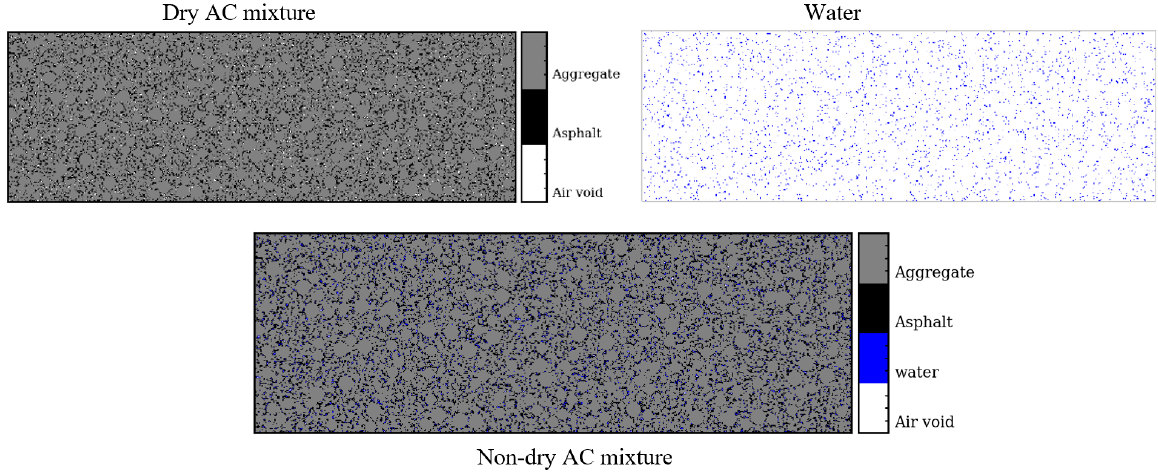
Figure 4. Visualization of a heterogeneous dry AC mixture, water component, and a non-dry AC mixture numerical model.